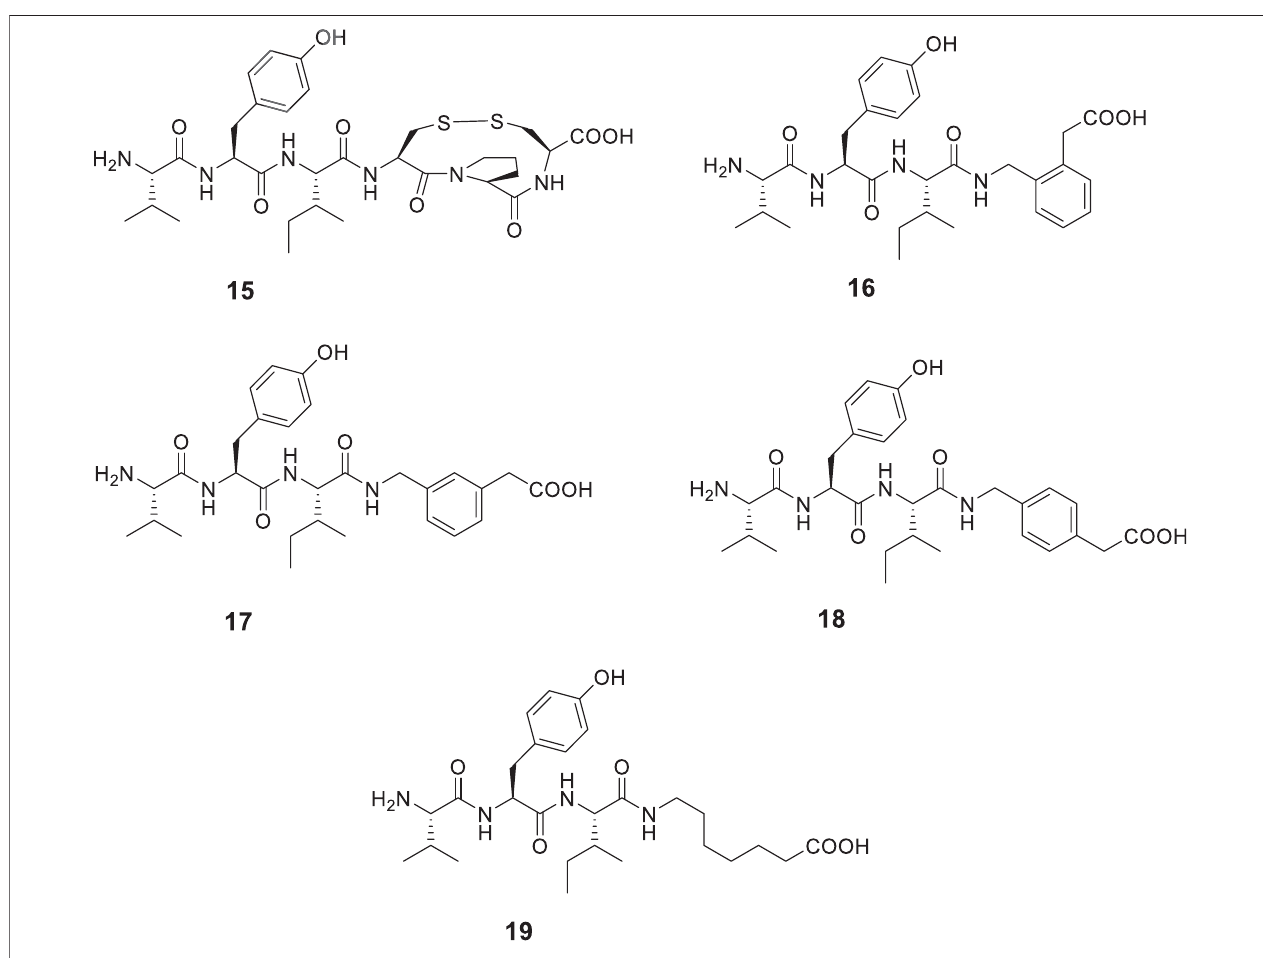
Figure 5 | Modi fi cations in the C-terminal. Compound 15 with an 11-membered macrocyclic ring adopting a γ -turn in the C-terminal binds better than Ang IV to IRAPand 16 withascaffoldservingasa γ -turnmimeticincorporatedinthe C-terminal isessentiallyasactive asAngIV.Compounds 17 , 18 , and 19 bindtoIRAP but are more than fi ve-fold less